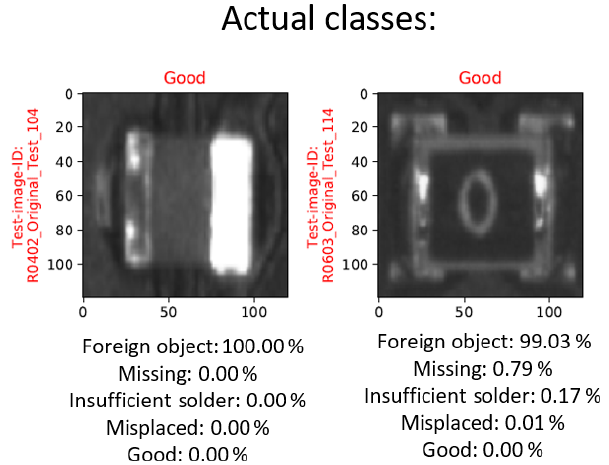
Figure 6. Classification results of resistors (test dataset Te_C2) with training dataset